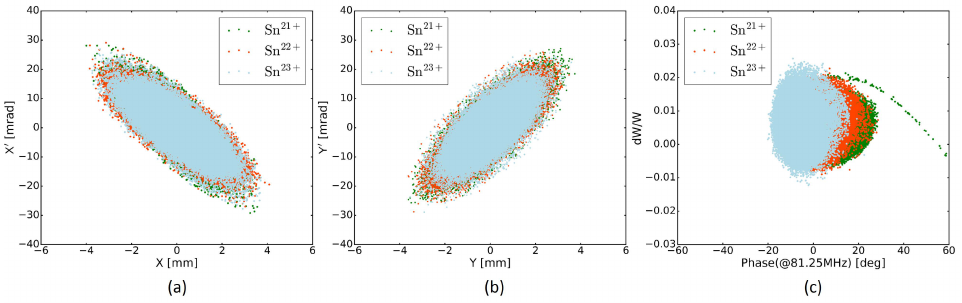
Figure 9. Output phase distribution of the high-charge-state mixed beam. ( a ) Distribution in X-X (cid:48) direction, ( b ) Distribution in Y-Y (cid:48) direction, ( c ) Distribution in Phase-dW/W direction. Table 3. Simulation result of three high-charge-state mixed ions.